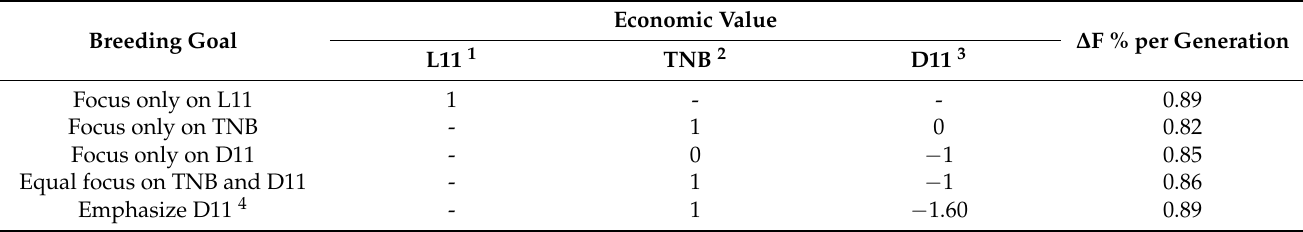
Table A1. Increase in inbreeding ( ∆ F) expressed in % per generation when using different breeding goals. Breeding